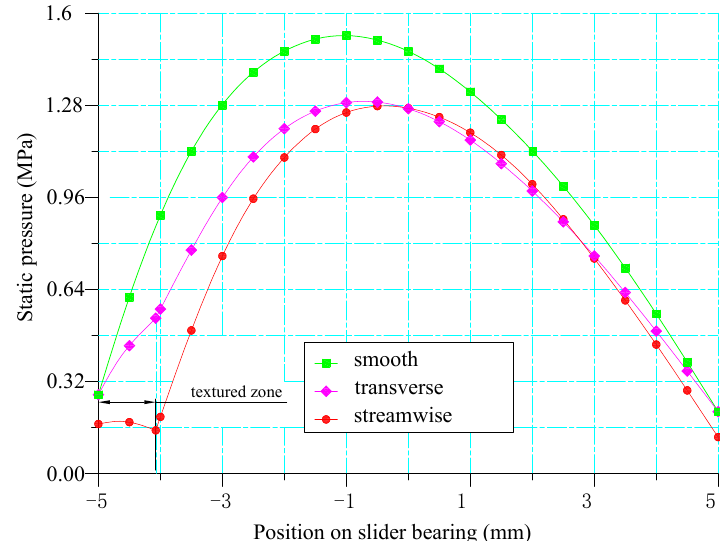
Figure 11. Influence of local texture on oil film pressure